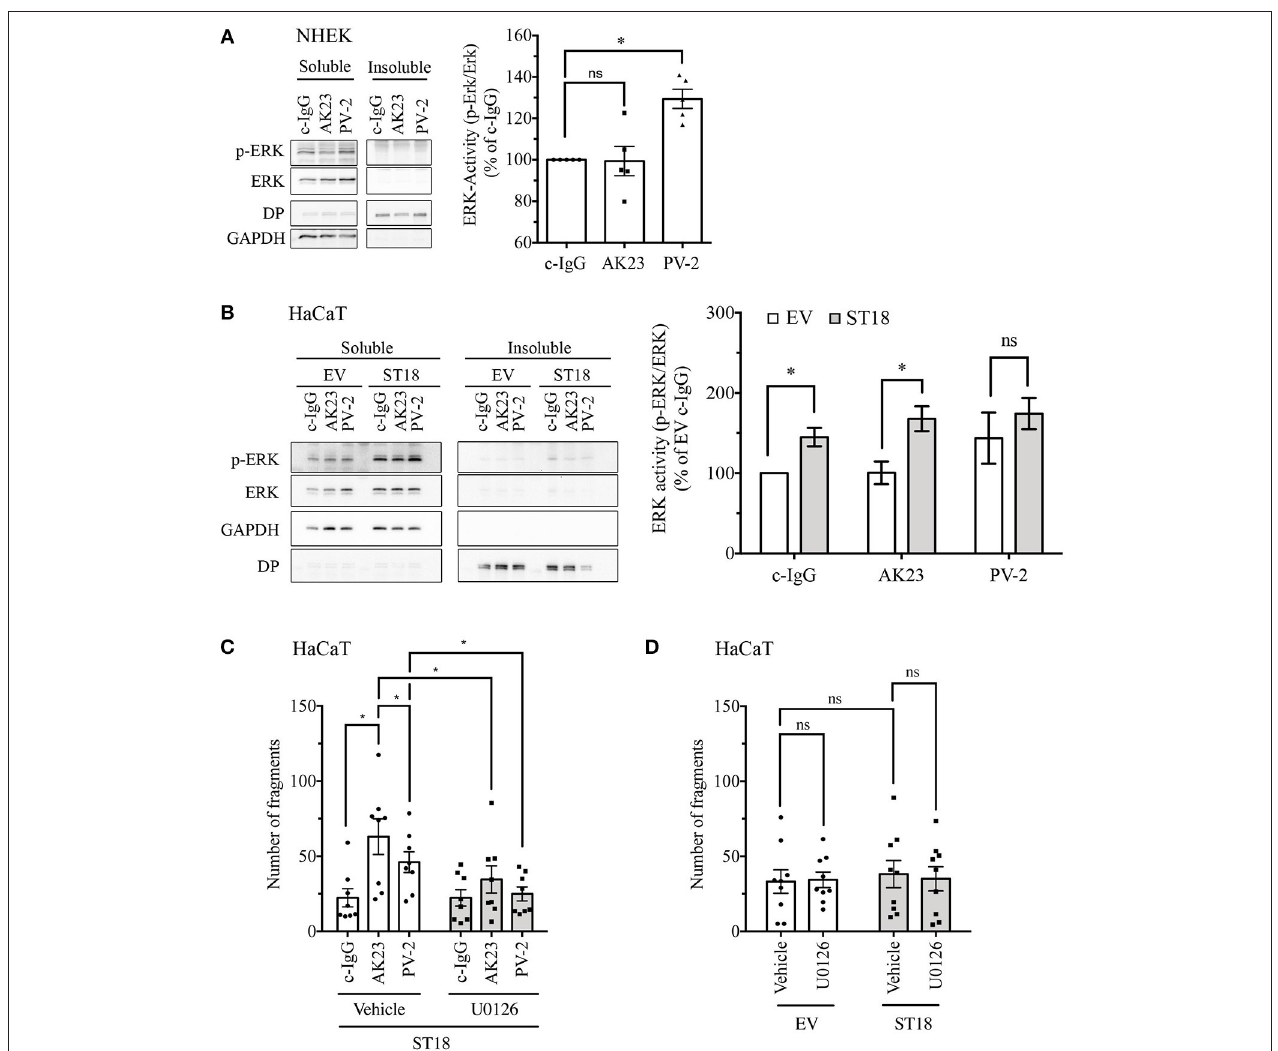
FIGURE 4 | Modulation of ERK signaling after incubation with pemphigus autoantibodies and ST18 overexpression. Twenty four hours after differentiation, NHEK cells were exposed for 30min to different IgG fractions. Triton X-100-soluble (cytosolic) and Triton X-100-insoluble (representing cytoskeletal- bound) fractions were generated and further analyzed by Western blot. (A) Representative blot of ERK phosphorylation in response to IgG for each Triton X-100 fraction produced. GAPDH was used as a cytosolic marker, while Desmoplakin (DP) served as a cytoskeletal-bound marker. Densitometric quantification of ERK activity ( n = 5, One-Way ANOVA, * p < 0.05 vs. c-IgG). (B) Triton X-100 fractionation of HaCaT cells transfected with EV or ST18 vector and treated with IgG fractions for 30min. Representative western blots showing total and phosphorylated ERK with respective markers for protein fractionation. Densitometric analysis of ERK activity within the soluble fraction using ImageJ software ( n = 7, multiple T -tests, * p < 0.05). (C) In HaCaT cells, 24h after ST18 transfection an U0126 was applied for an hour followed by 2h incubation with different IgG fractions, as indicated. Dispase-based assay evaluating the effect of ST18 mediated ERK activation in cell monolayers treated